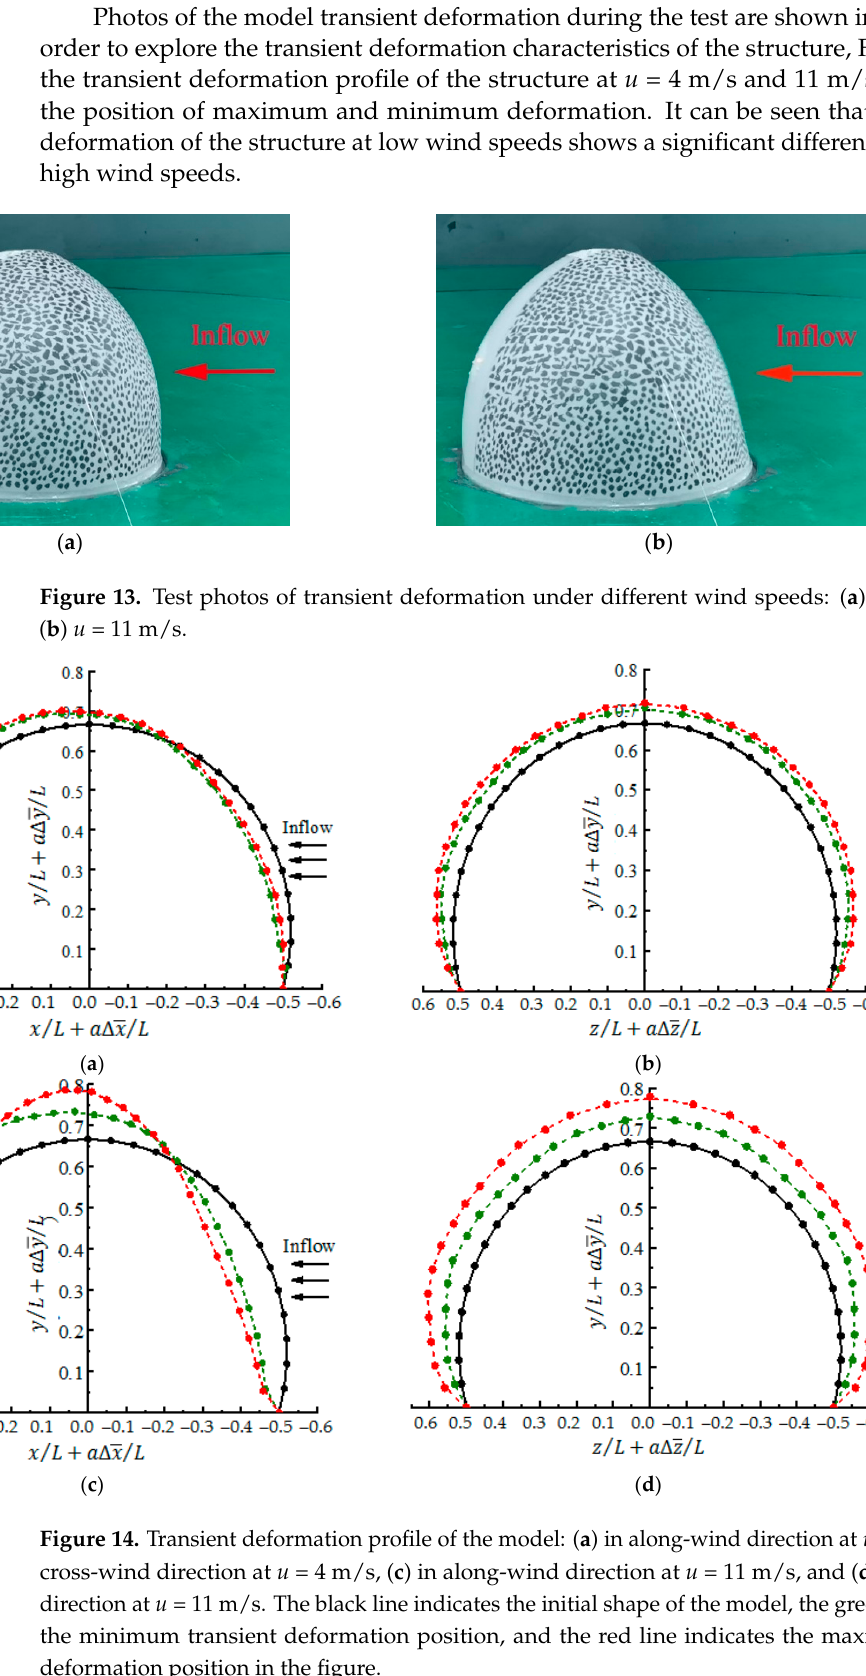
Figure 12. Average deformation profile of the model: ( a ) average deformation profile in xy plane and ( b ) average deformation profile in yz plane.